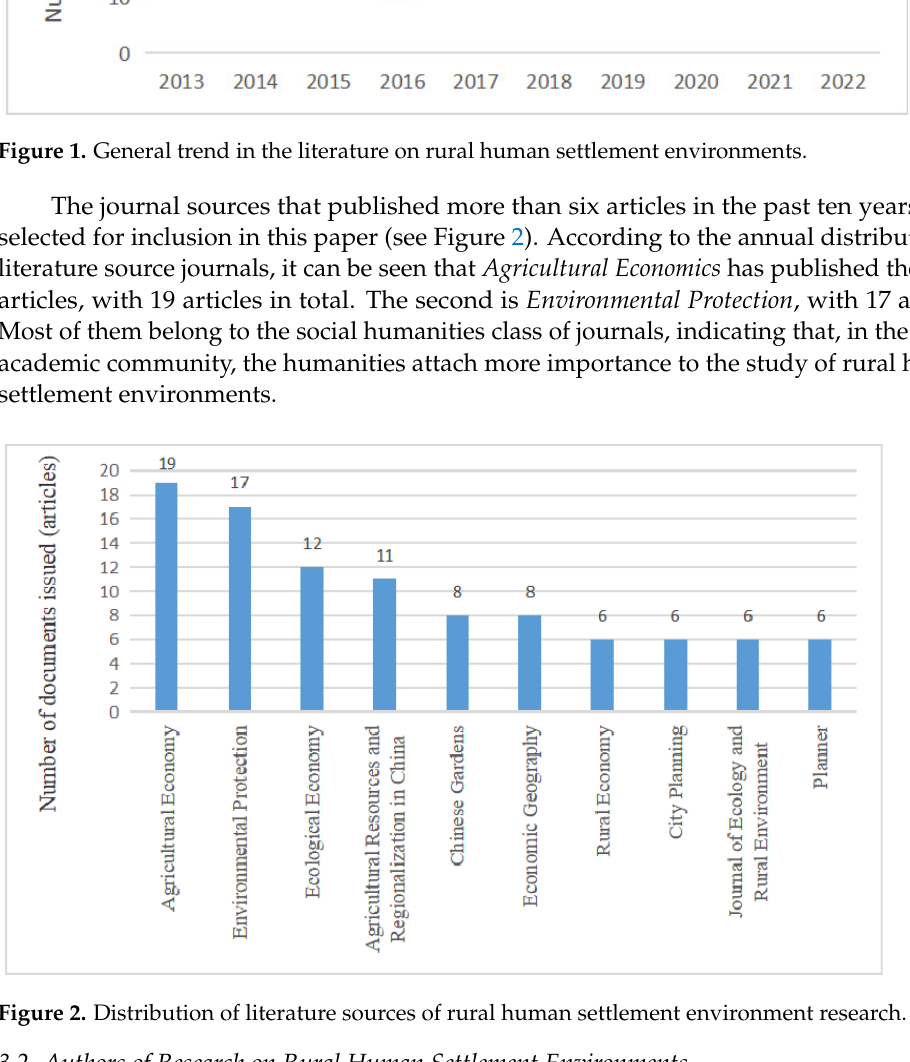
Figure 2. Distribution of literature sources of rural human settlement environment research.